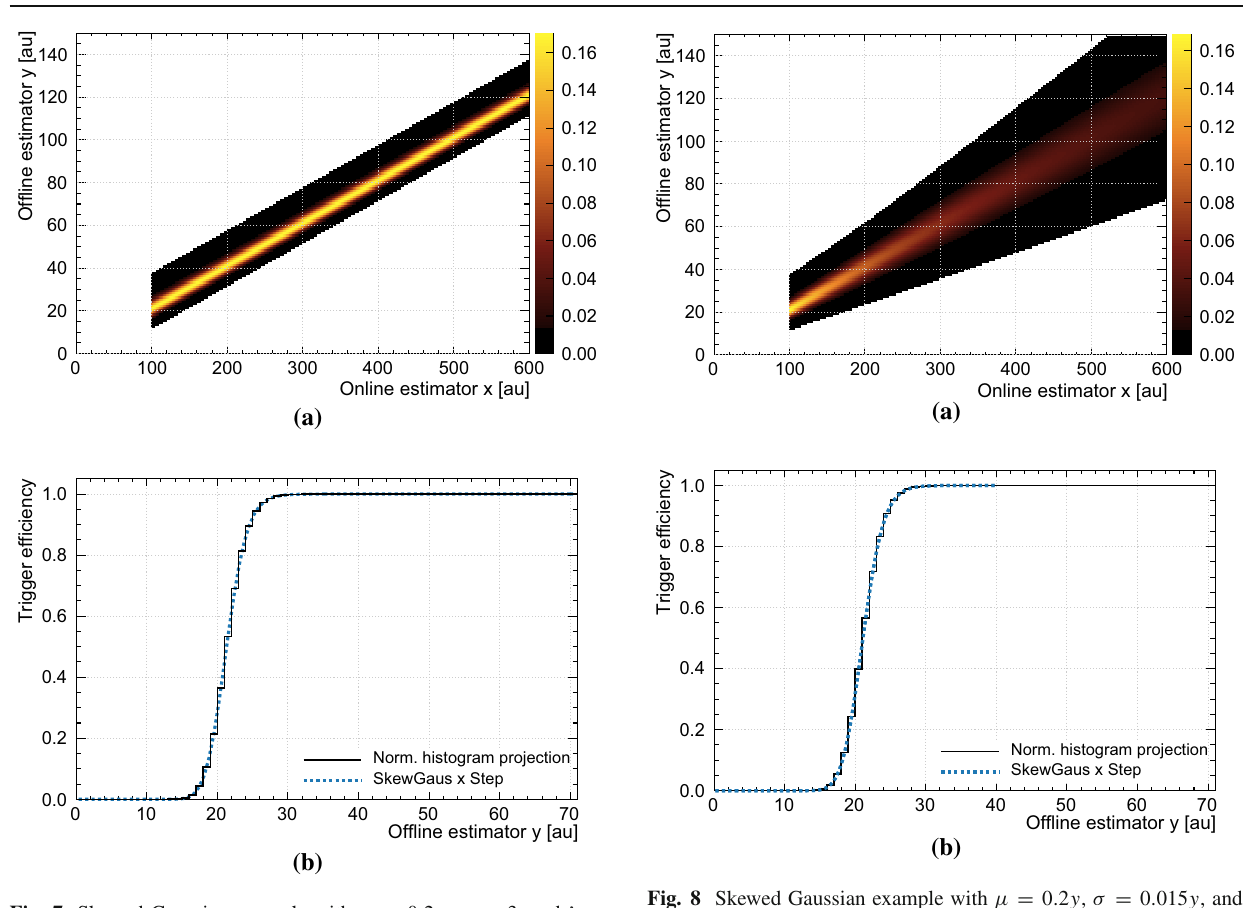
fails if μ or σ are polynomials of order bigger than 1 in y .